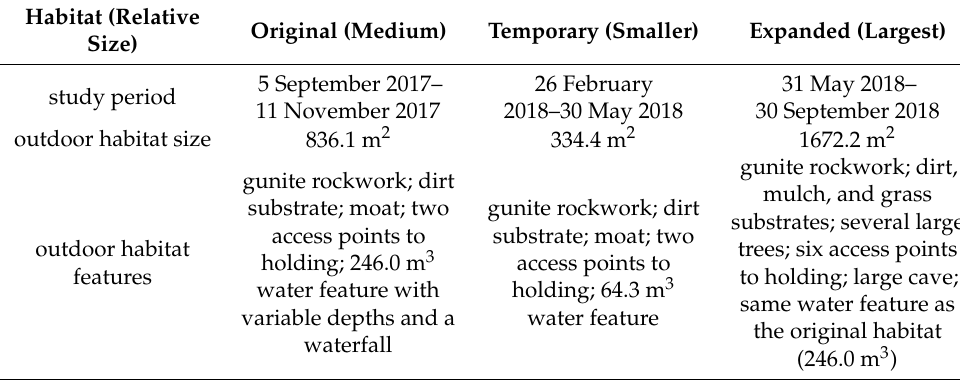
Table 1. Grizzly bear habitats occupied during the